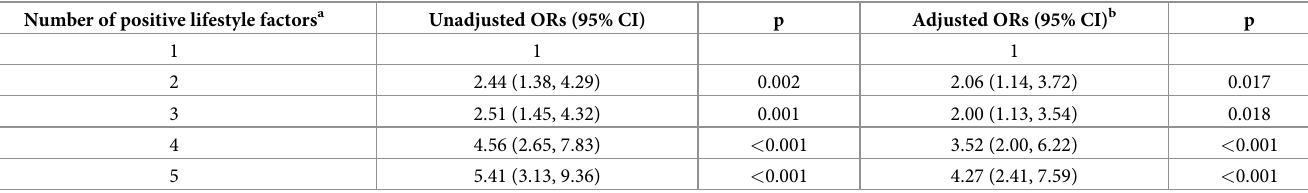
a The lifestyle index was a sum of the following positive lifestyle factors: no smoking, high physical activity, low alcohol consumption, no obesity, and good social support b Adjusted OR: Adjusted for age, gender and educational